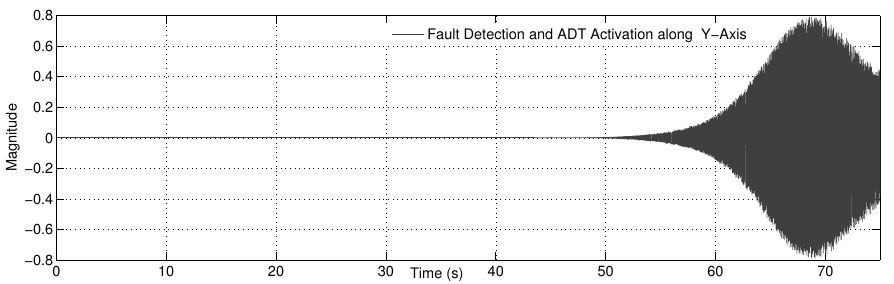
Figure 10. Fault detection scheme along the x -axis.